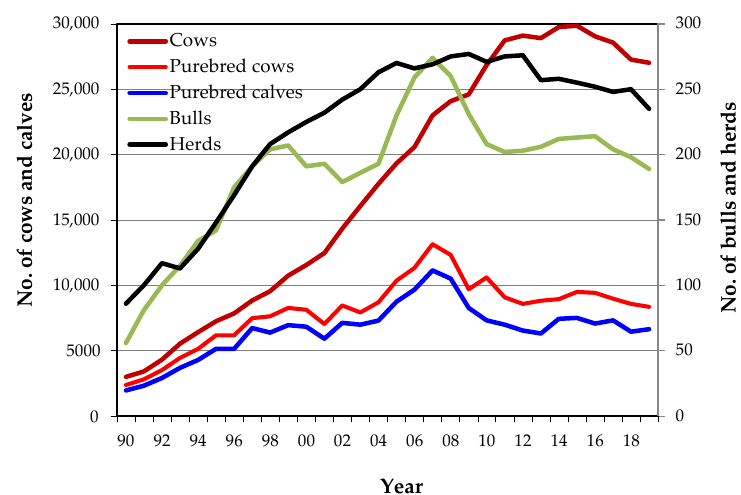
Figure 2. Number of cows, bulls, calves and herds registered in the Mertolenga’s Herdbook by year.